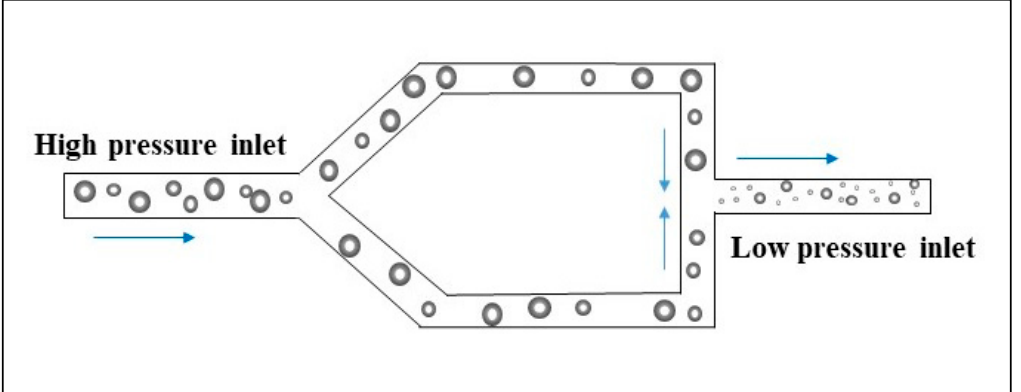
Figure 3. Schematic image of a high pressure microfluidizer.